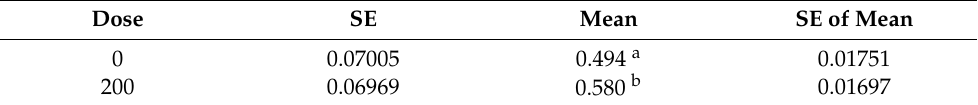
Table 2. Dose least squares means, using generalized linear model (GLM), with GENMOD procedure, under binomial distribution (pregnant/not pregnant) and in logarithmic function (PROBIT), by source as “dose of eGAL-1”, that means dose 0 = GC and dose 200 = TG, using SAS software, Version 6.9. Dose SE